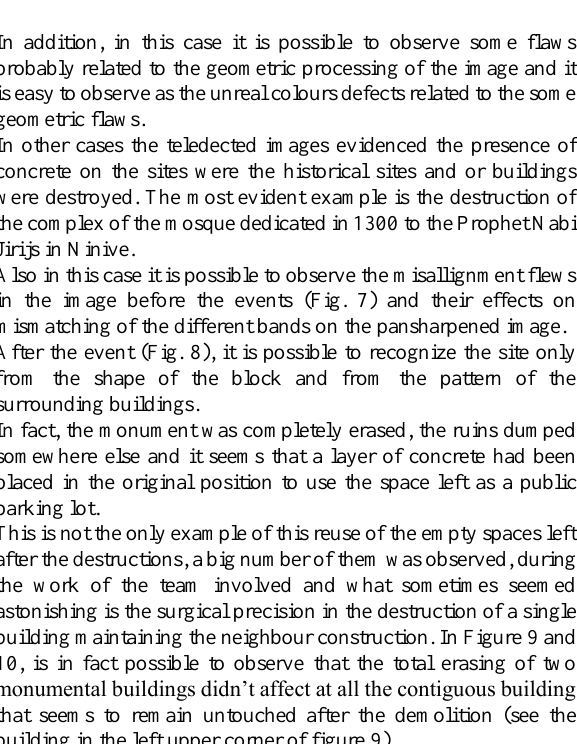
Figure 6. Mosque and sacred place of al-Nabi Sheet after the